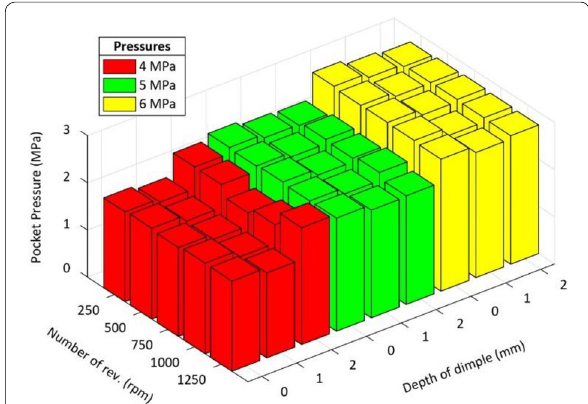
Figure 9 Pocket pressure values under different study parameters for different dimple depths